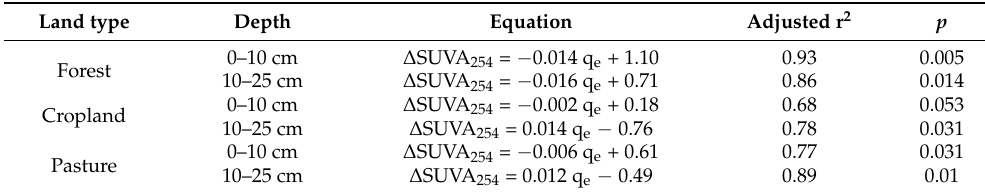
Table 3. Linear regression between the change in SUVA 254 of a DOC solution and equilibrium DOC concentration for three land type soils at 0–10 cm and 10–25 cm